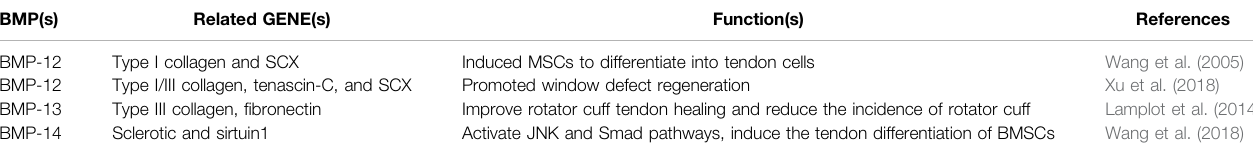
TABLE 3 | Functions of BMPs in tendon/ligament